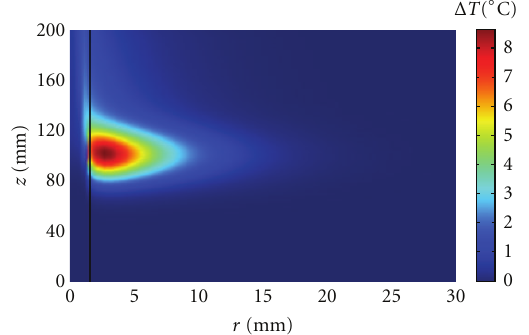
Figure 1: Axial symmetrical temperature increase reached at the end of a 60s insonation period in a large artery ( R = 1 . 5mm, / s). The ultrasound beam is directed L = 200mm, V m = 13cm Figure 2: Axial symmetrical temperature increase reached at the downward and the blood flow is moving upward. end of a 60s insonation period in a primary artery ( R = 0 . 5 mm, L = 100 mm, V m = 8cm/s). The ultrasound beam is directed downward and the blood flow is moving